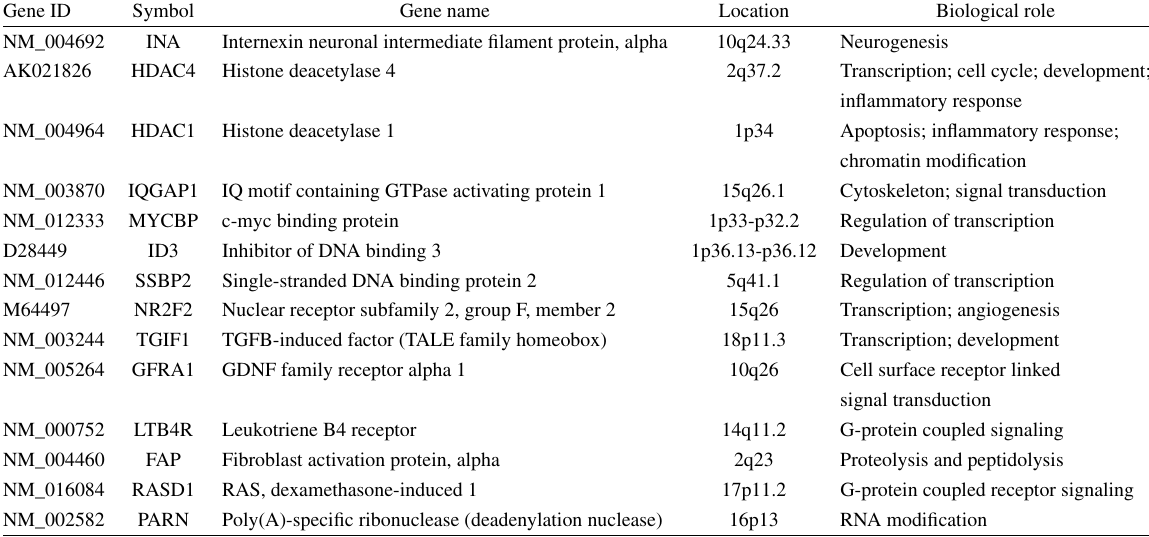
Genes analyzed by real-time